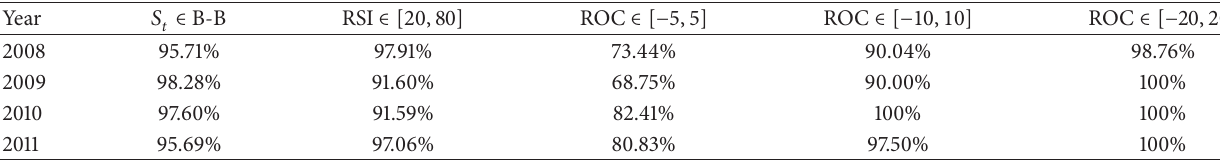
Table 1: Ratio of SPY in 2008–2011.